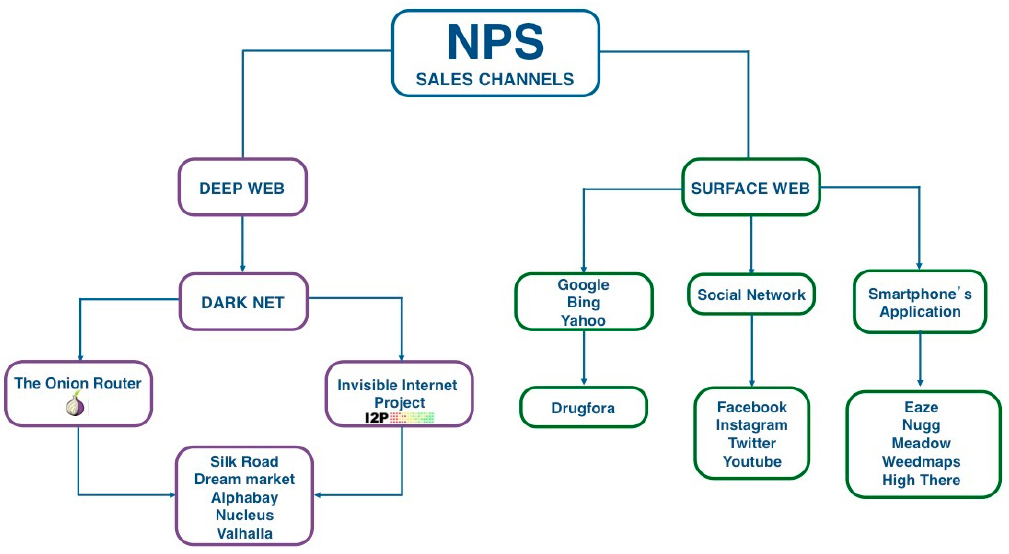
Figure 1. NPS marketing, advertising, and communication network.